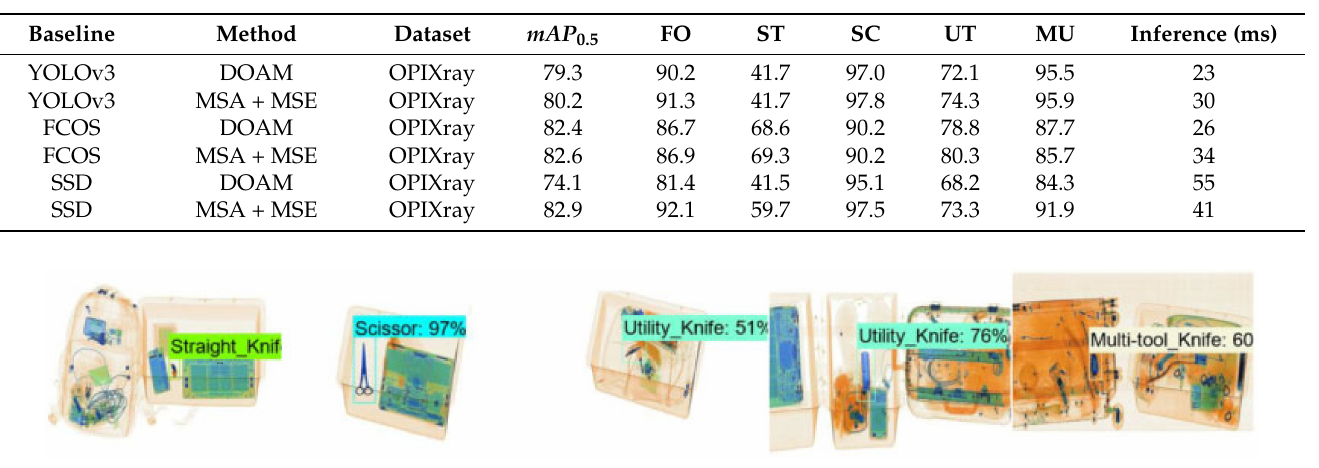
Figure 15. OPIXray data set prediction